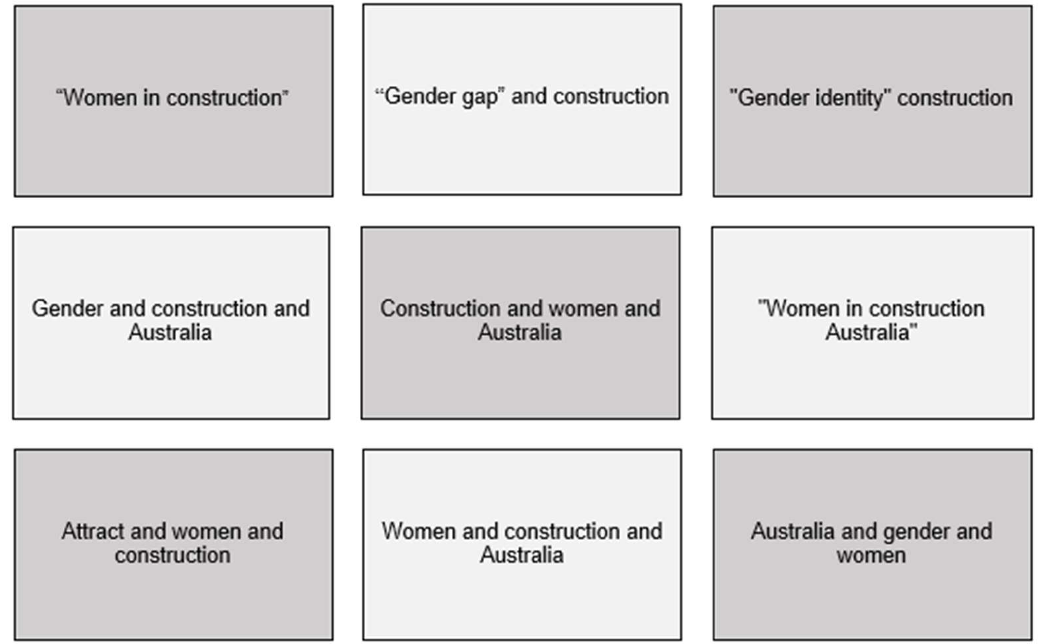
Figure 3. Keywords and phrases used when sourcing relevant articles.